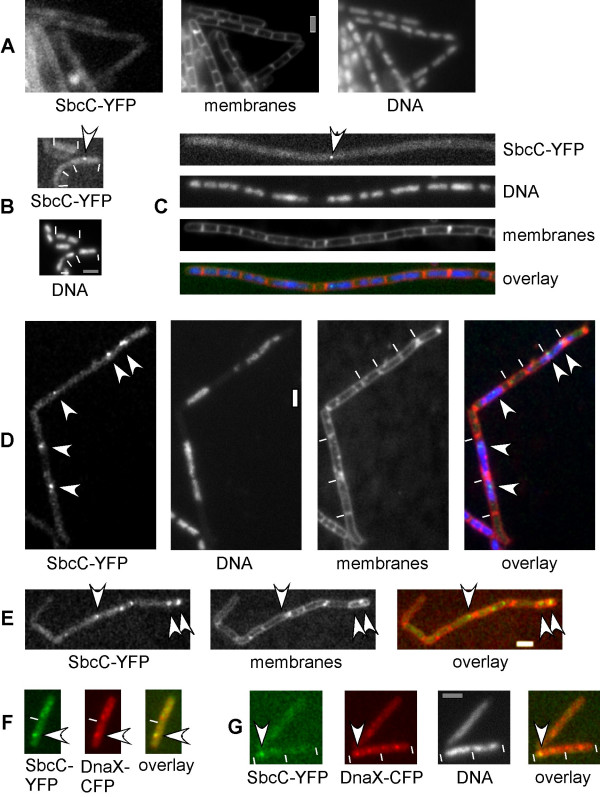
Fluorescence microscopy of Bacillus subtilis cells. A-B) Strain JN6 (sbcC-yfp) growing exponentially, or C) 30 min or D) 120 min after addition of 50 ng/ml of MMC, or E) 120 min after addition of 200 ng/ml of MMC. F-G) Strain JM61 (dnaX-cfp, sbcC-yfp) 120 min after addition of MMC. White arrowheads indicate the localization of SbcC-YFP and co-localization of the protein fusions. White lines indicate septa between cells. White bars 2 μm.